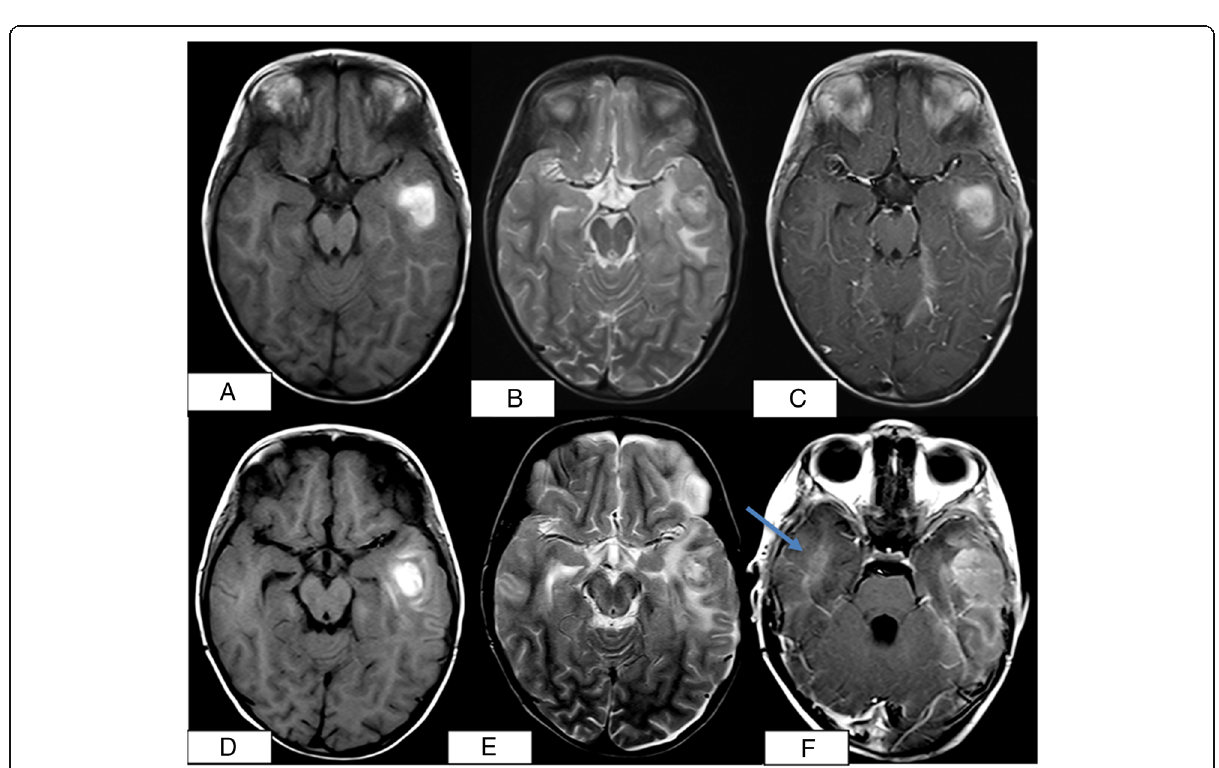
Fig. 2 MRI examinations of a 5-year-old post-allogenic HSCT patient presenting with convulsions. a , b and c Initial MRI examination: axial T1WI ( a ), axial T2WI ( b ), and post-contrast axial T1WI ( c ) sequences revealed left temporal intra-axial SOL showing high T1WI signal, heterogenous T2WI signal, and heterogeneous post-contrast avid enhancement with related mild meningeal enhancement. Subsequent mass effect is noted evident as effacing the overlying sulci, compressing the ipsilateral temporal horn. The patient was initially diagnosed as a case of left temporal intra- parenchymal hematoma. Marked deterioration of the patient required follow-up MRI examination after 3 weeks. d , e , and f Axial T1WI ( d ), axial T2WI ( e ), and post-contrast axial T1WI ( f ) sequences revealed a rather stationary course of the previously noted SOL with markedly evident related meningeal enhancement and newly developed right temporal lobe meningeal enhancement (blue arrow). Pathology after temporal lobectomy revealed relapsed B cell non-Hodgkin